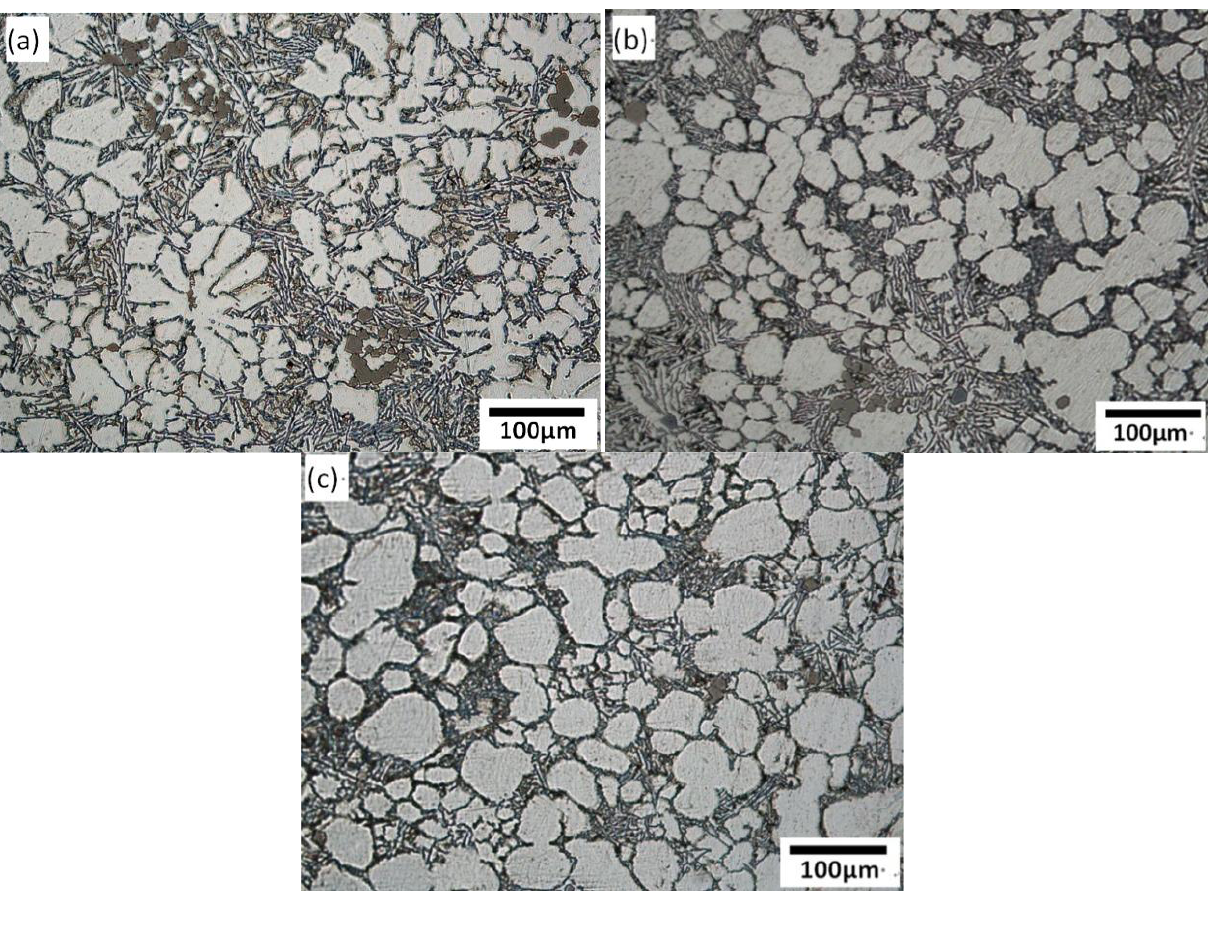
Figure 7. Optical micrographs of semisolid A380 alloy under different rotational speed: ( a ) 100 r/min; ( b ) 300 r/min; ( c ) 500